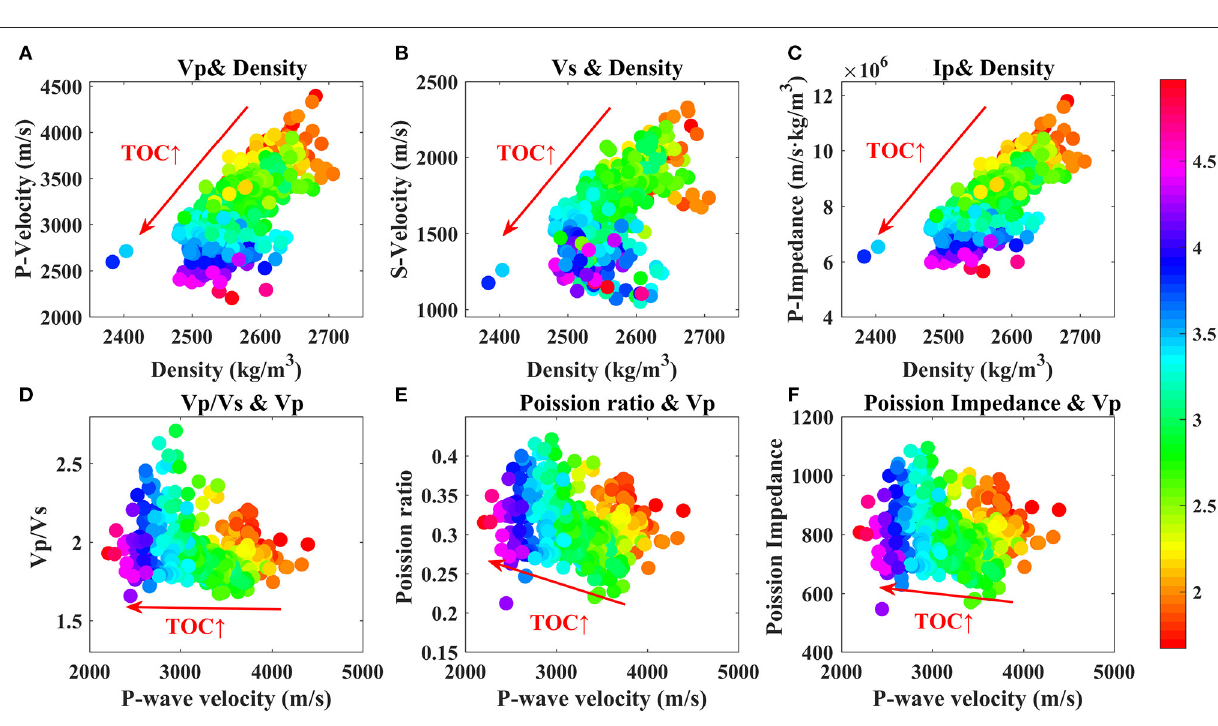
Frontiers in Earth Science |